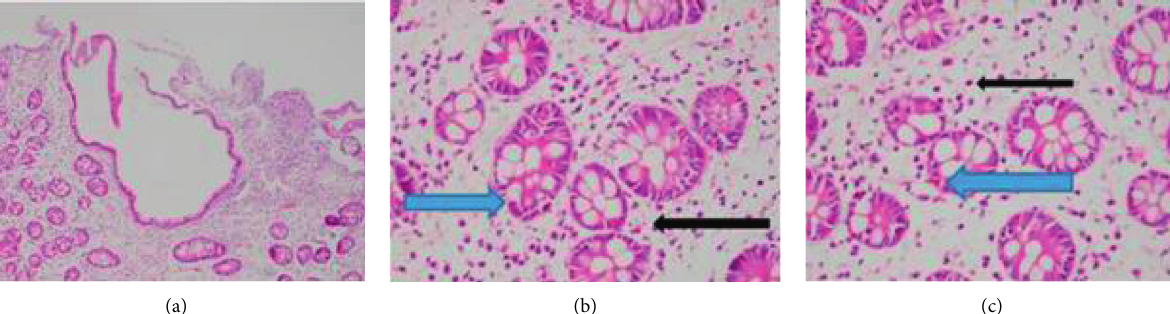
Figure 4: Histologic findings of duodenal biopsy; the duodenum mucosa shows (a) villous atrophy, architecture changes, and edematous lamina propria, (b) plasma cells (black arrow), and (c) cryptitis (blue arrow) in the lamina